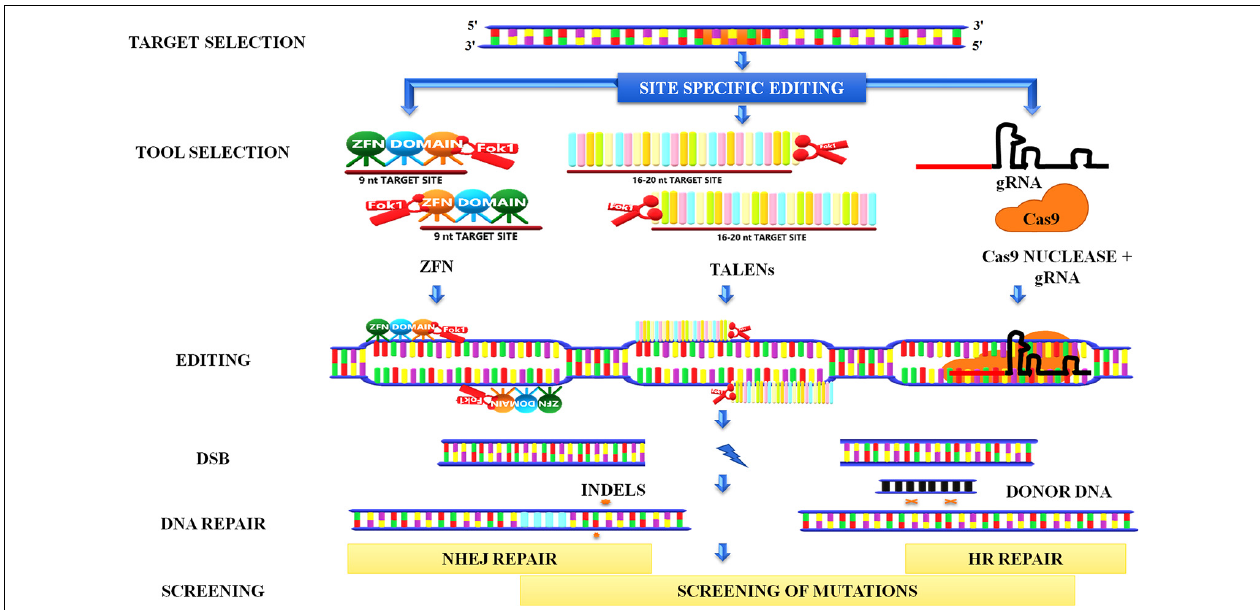
FIGURE 10 | Genome editing. Site-directed genome editing involves the induction of site-specific double-stranded breaks in the genome followed by the recruitment of endonucleases such as ZFNs, TALENs, CRISPR-Cas9. ZFN recognizes nine nucleotide sites on binding and creates a break when two FokI monomers are in proximity to each other. TALENS also works in a similar manner. In the CRISPR system, a gRNA binds to the target site in the genomic region and forms a complex with Cas 9 nuclease to create a break. These breaks can further be repaired by NHEJ, which inserts indels in the sequence, or by HRR pathways in which homolog donor sequence could be used to modify the target sequence. ZFNs, Zinc-finger nucleases; TALENs, transcription activator–like effector nucleases CRISPR-Cas9, clustered regularly interspaced short palindromic repeats/CRISPR-associated protein 9; gRNA, guide RNA; FokI, a type IIS restriction endonuclease isolated from Flavobacterium okeanokoites ; NHEJ, non-homologous